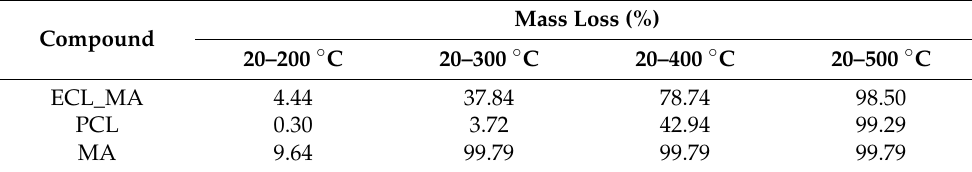
Figure 5. Thermograms of the ECL_MA co-polyester (green line), polycaprolactone (PCL) homopolymer (blue point line), and MA monomer (purple dashed line). Table 4. Mass losses over different temperature ranges of the ECL_MA co-polyesters, polycaprolac- tone (PCL) homopolymer, and MA monomer,